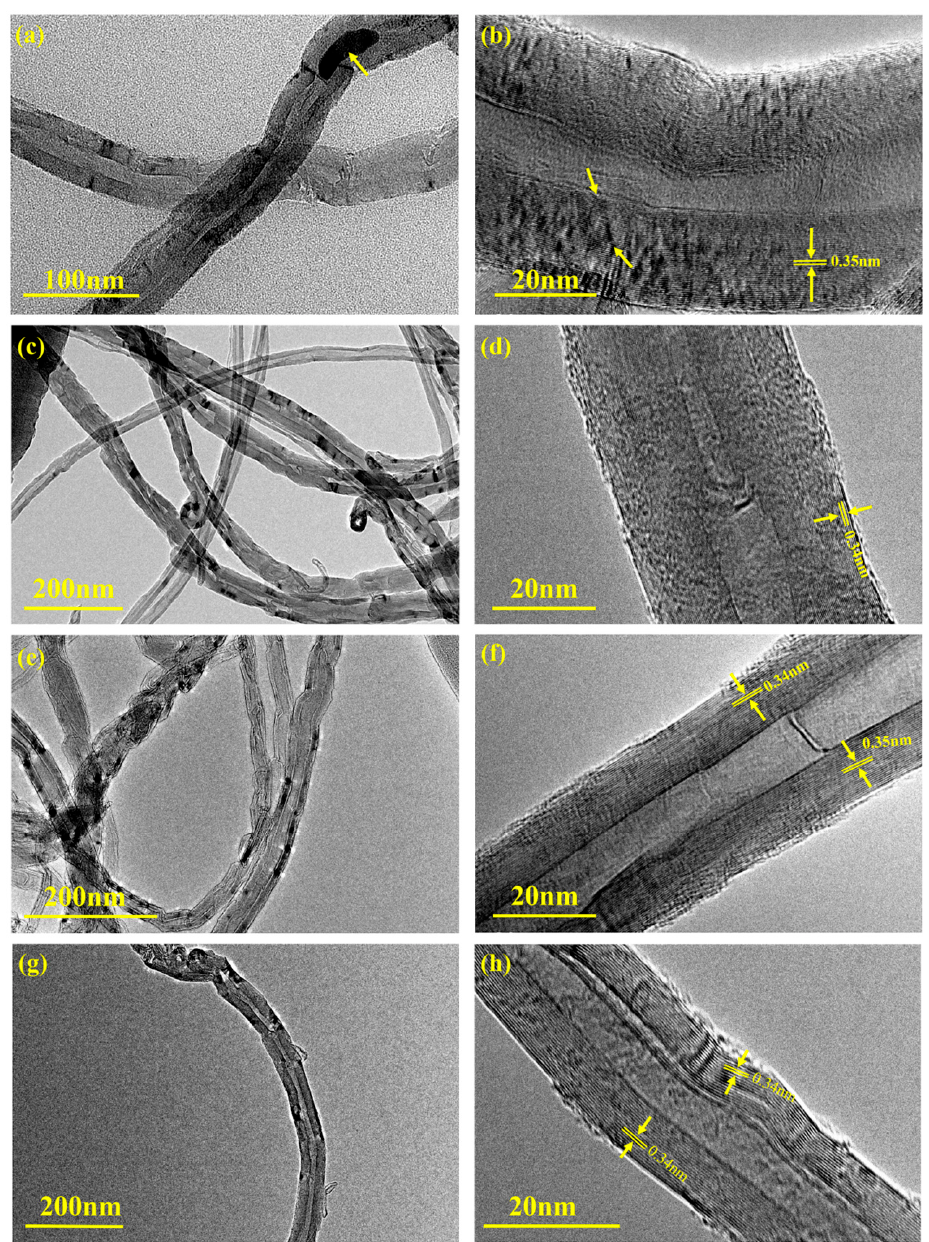
Figure 5. Characterization of MWNTs, TEM images of ( a , b ) undiluted MWNTs; ( c , d ) MWNTs annealed at 2200 °C; ( e , f ) MWNTs annealed at 2400 °C; ( g , h ) MWNTs annealed at 2800 °C.